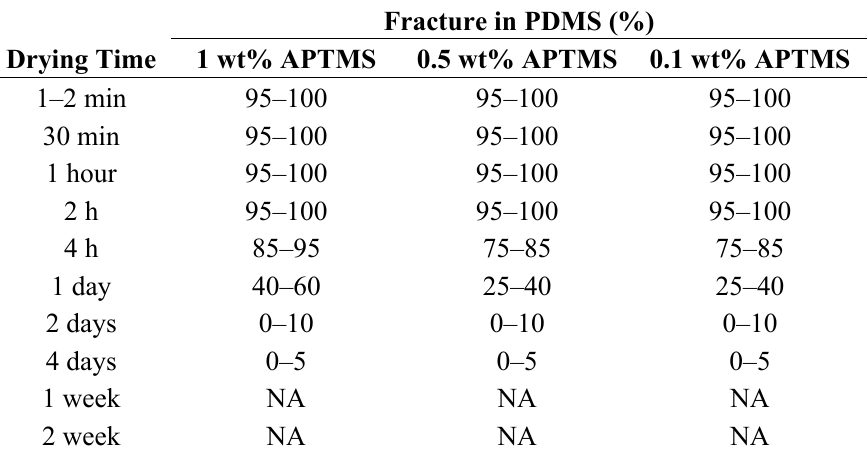
Table 2. Effect of drying time of APTMS treated PDMS on bonding to